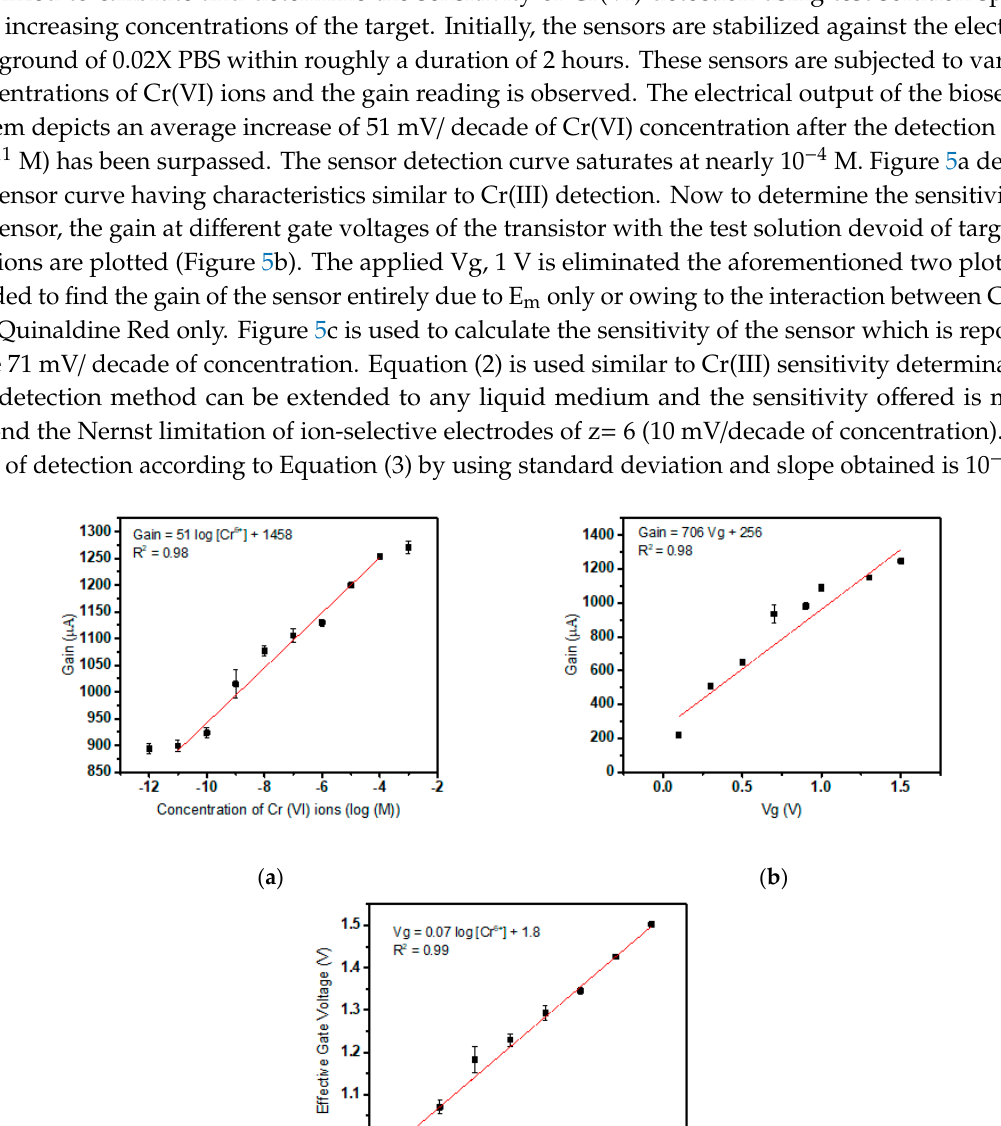
Figure 4. ( a ) Sensor detection curve of Cr(III) target ion; ( b ) Gain versus applied gate voltage